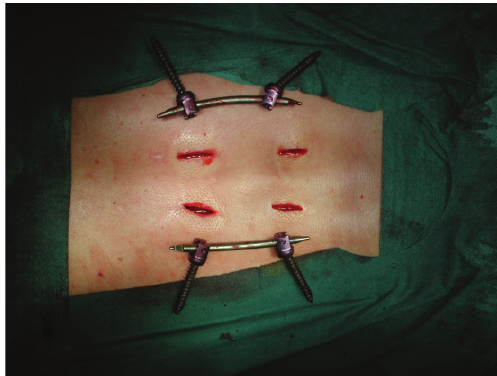
Figure 3: Percutaneous minimal invasive removal of the instru-